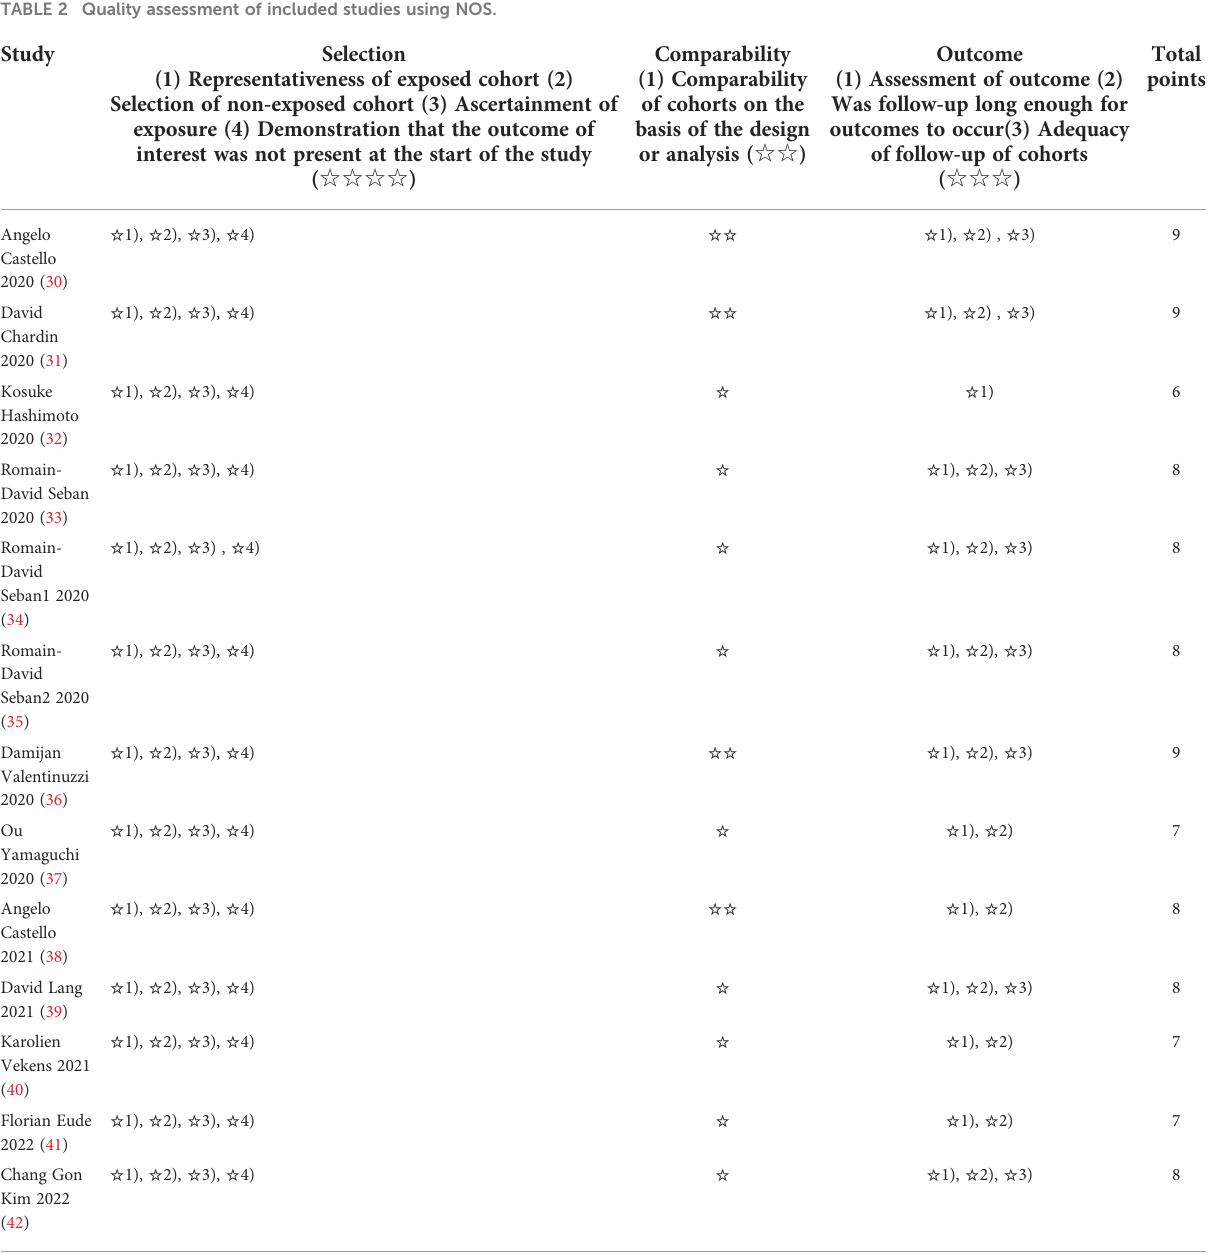
TABLE 2 Quality assessment of included studies using NOS. Study Selection Comparability Outcome Total points(1) Representativeness of exposed cohort (2) (1) Comparability (1) Assessment of outcome (2) Selection of non-exposed cohort (3) Ascertainment of of cohorts on the Was follow-up long enough for exposure (4) Demonstration that the outcome of basis of the design outcomes to occur(3) Adequacy interest was not present at the start of the study or analysis ( ☆☆ ) of follow-up of cohorts ( ☆☆☆☆ ) ( ☆☆☆